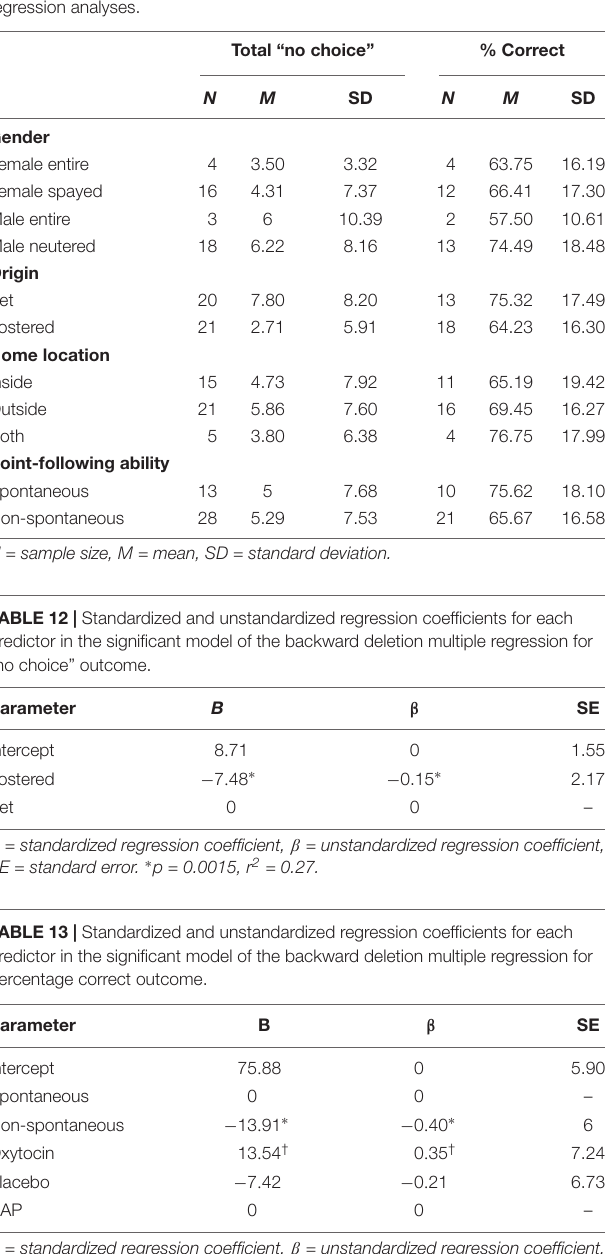
TABLE 11 | Means and standard deviations for the categorical variables “Gender,” “Origin,” “Home Location,” and “Point-Following Ability” included in the multiple regression analyses.